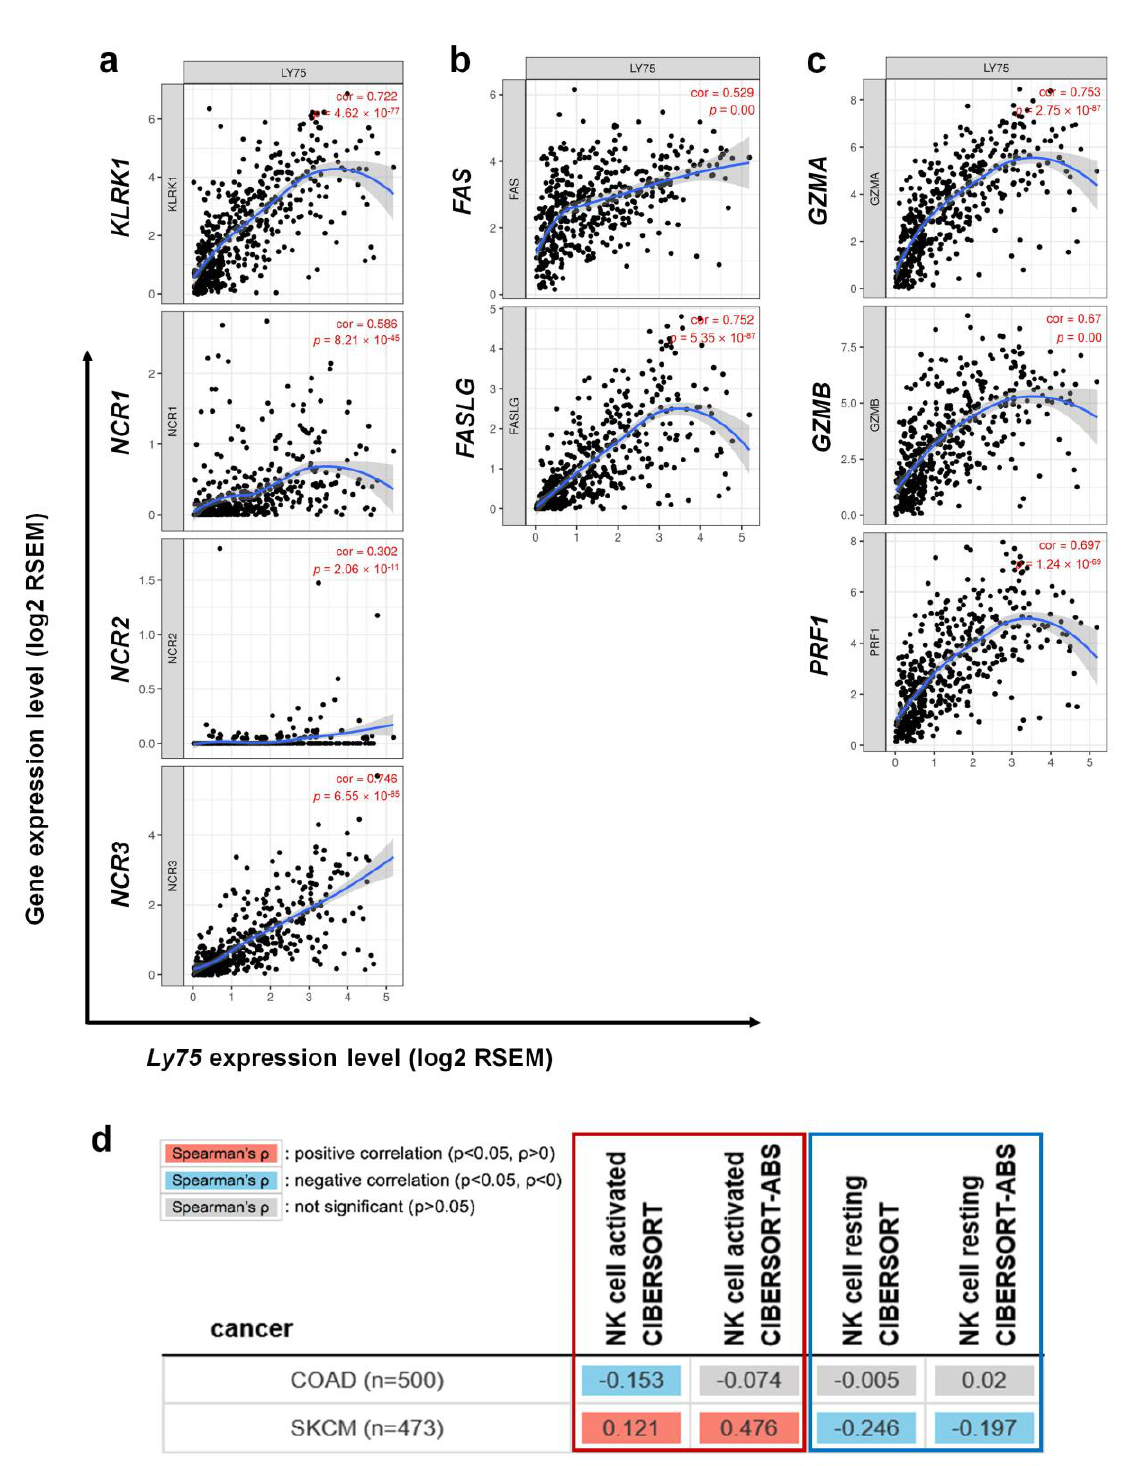
Figure 5. Correlation of Ly75 with signature genes of NK cell cytolytic activity in SKCM. Expression correlations of Ly75 and genes related to NK cell activation were explored with TIMER. ( a ) Activation receptors of activated NK cells, ( b ) FAS and the FAS ligand, and ( c ) Cytotoxicity signature genes. ( d ) Association of Ly75 expression with infiltration of activated NK cells (red box) or resting NK cells (blue box) was analyzed using TIMER2.0 web tool (http: // timer.cistrome.org / ). Gene signatures of activated NK cells and resting NK cells from CIBERSORT were used on the web